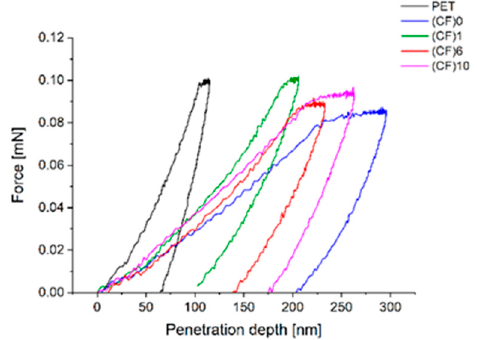
Figure 5. Sample indentation curves for PET substrate and substrate + coating systems.